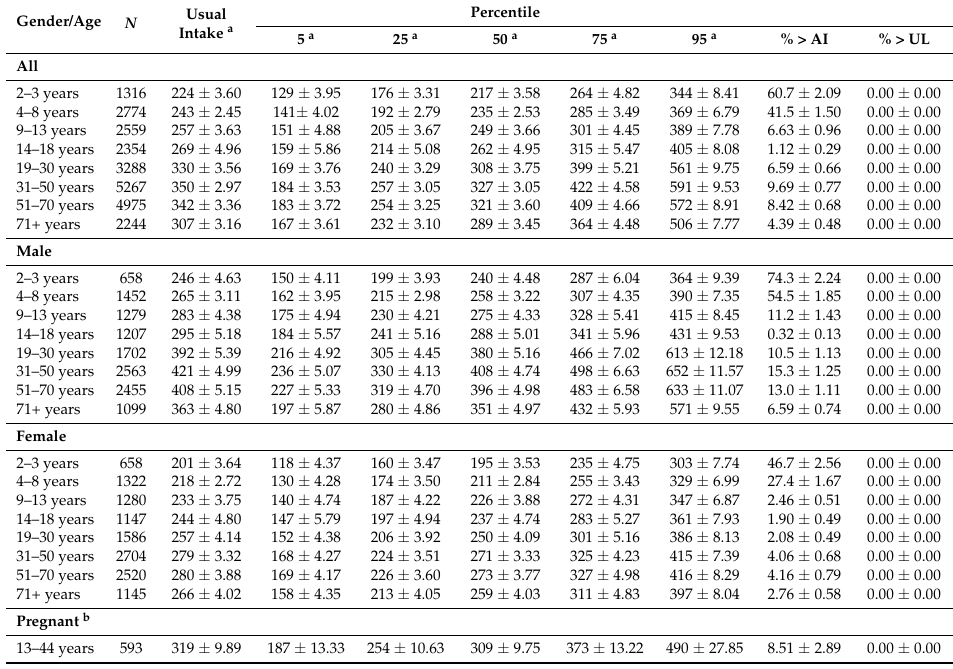
Table 2. Choline Intakes among individuals in the National Health and Nutrition Examination Survey (NHANES) 2009-2014 Datasets by Gender and Age a .